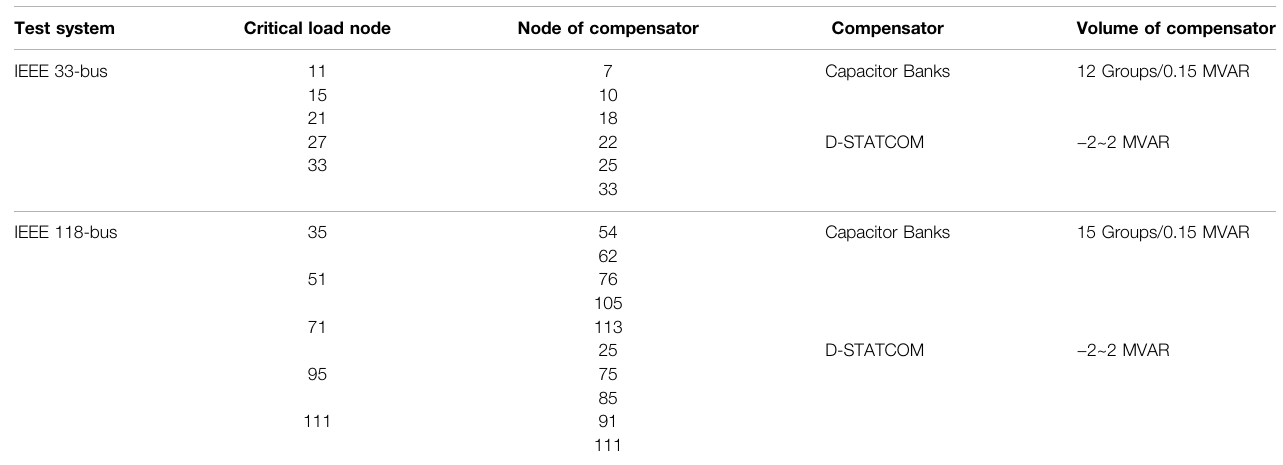
TABLE 1 | Con fi guration of test